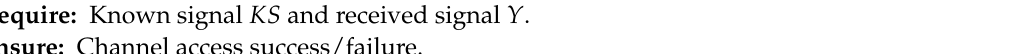
Algorithm 1 New carrier sensing